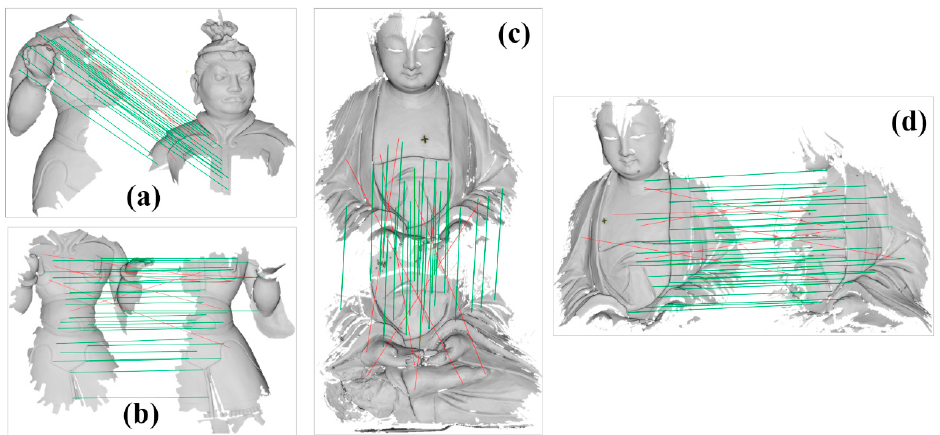
Figure 11. Correspondence establishment of the first iteration: ( a ) 18.5% incorrect ratio, ( b ) 20% incorrect ratio, ( c ) 21.4% incorrect ratio, ( d ) 15.8% incorrect ratio, green lines indicate the correct matches, while red lines indicate the incorrect matches.